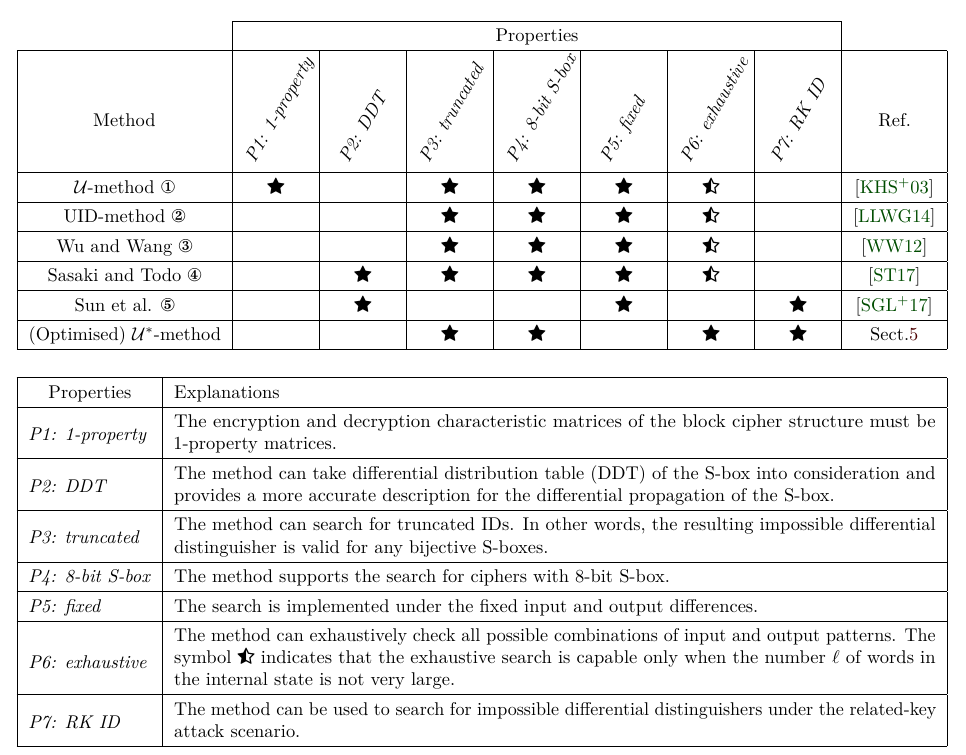
Table 1: Top : Comparison of all tools targeting (RK) IDs for SPN ciphers. Bottom : Explanations of